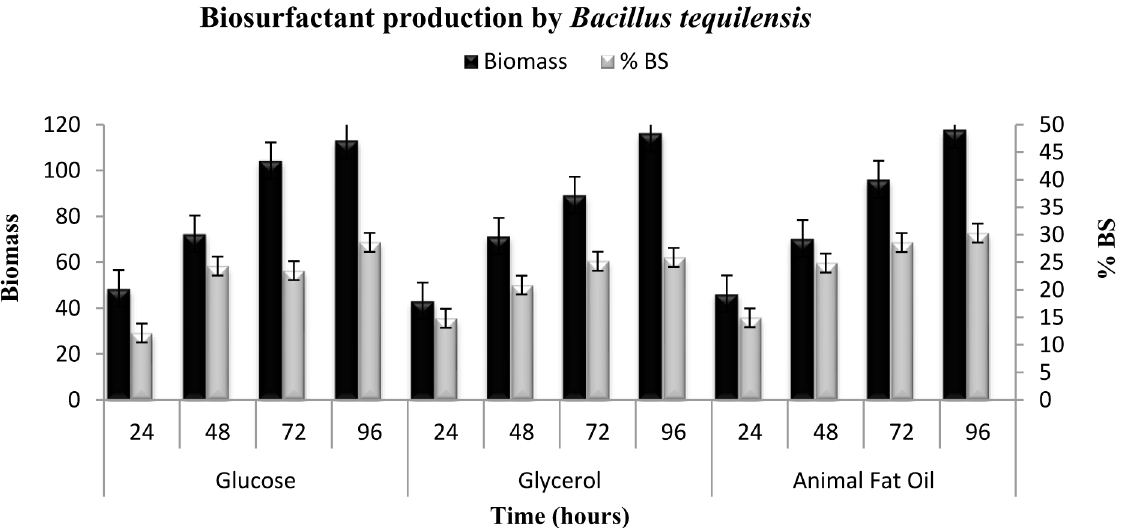
Figure 3: Time profiling for biosurfactant production by strain PWF ( Bacillus tequilensis ; MH142145) showed highest production on animal fat oil (35.7 g/L) while lowest biosurfactant production was on glycerol (30.1 g/L). Biomasses are the mean of values recorded during production kinetics. Standard error of each value was calculated.